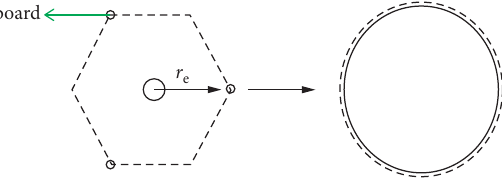
Figure 2: Simplified analysis model for the drainage